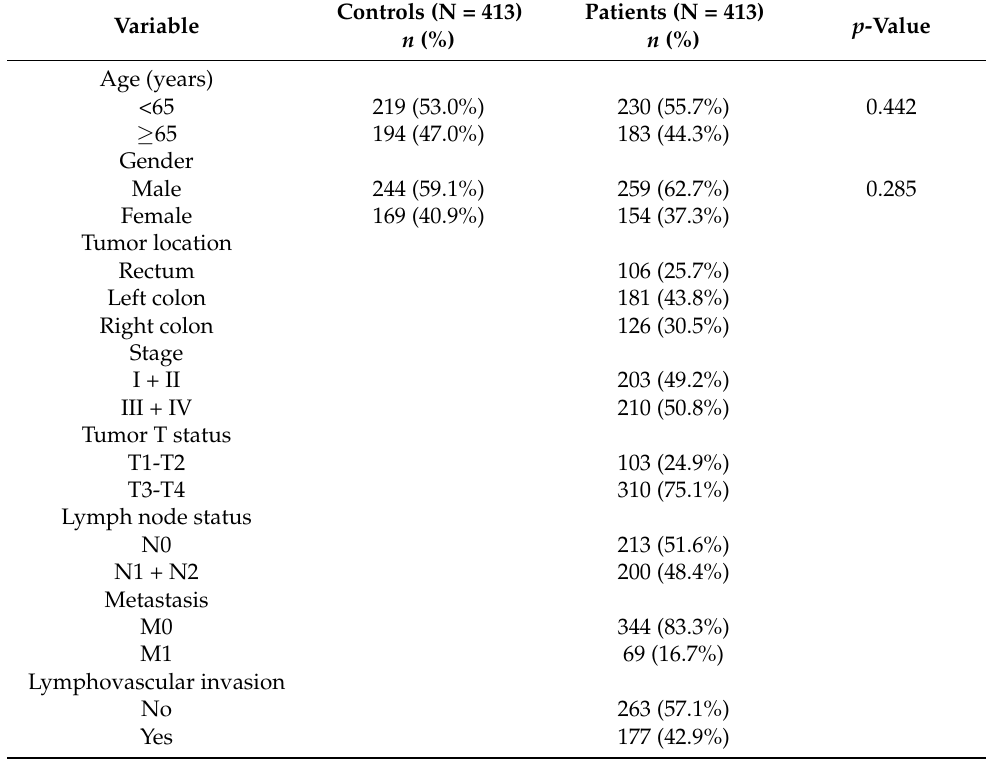
Table 1. The distributions of demographical characteristics in 413 controls and 413 patients with